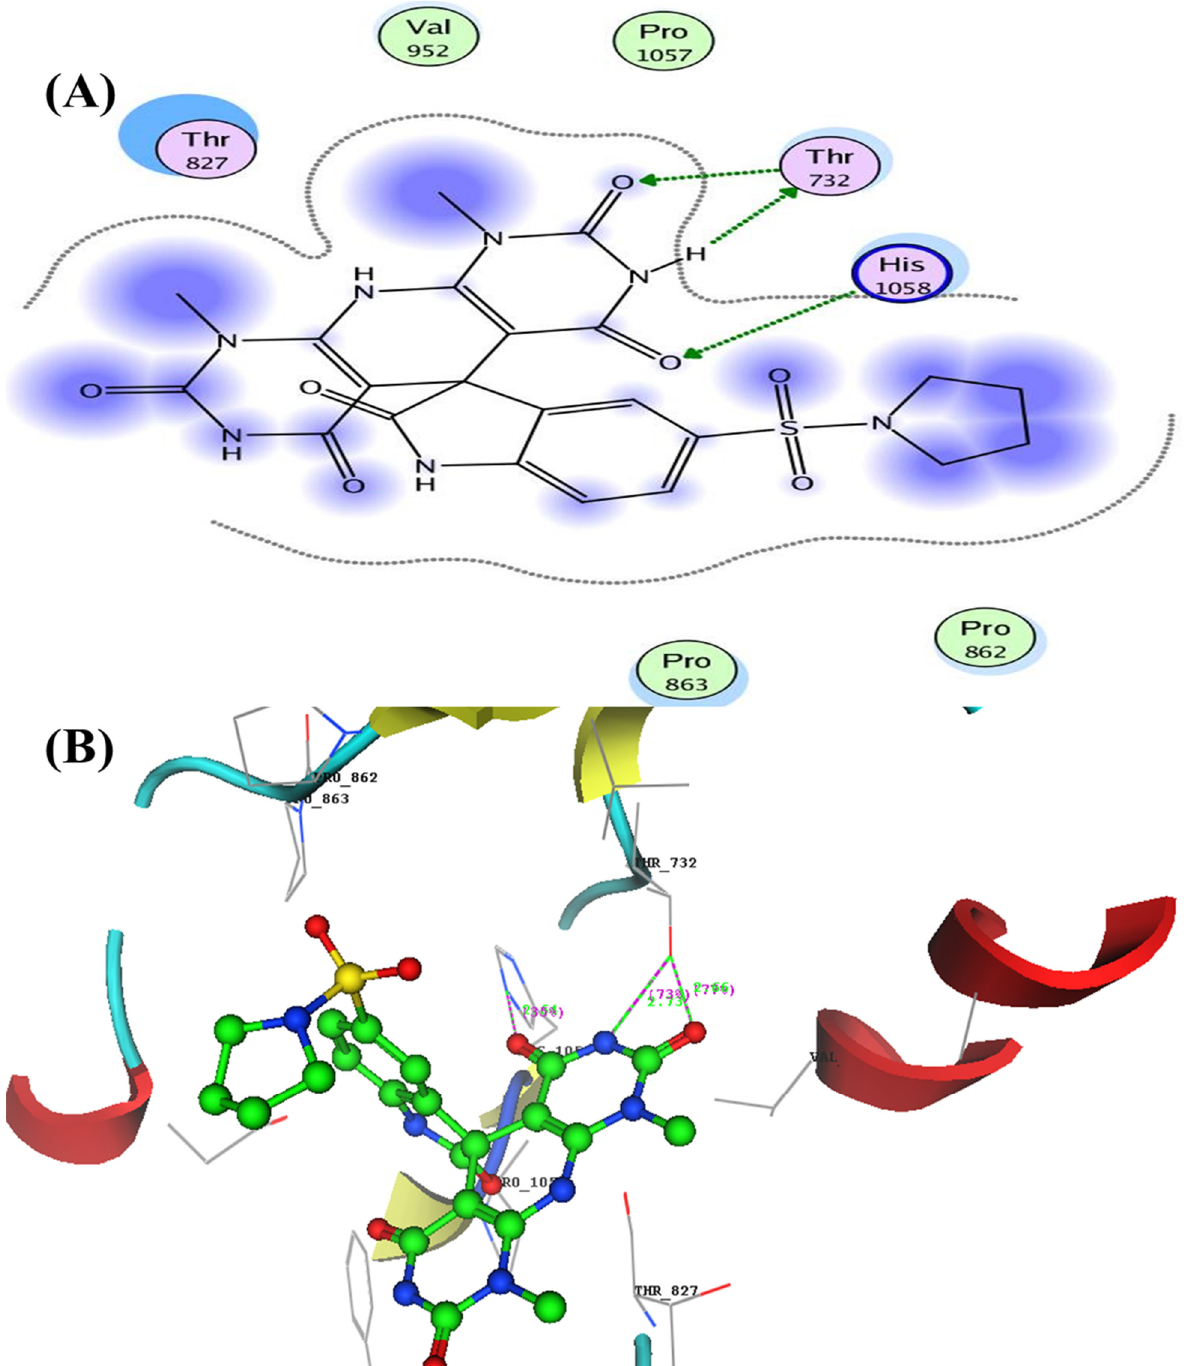
Figure 8. ( A ) 2D and ( B ) 3D structures of compound 3a inside the active site of spike glycoprotein (SGp) (PDB: 6VXX)